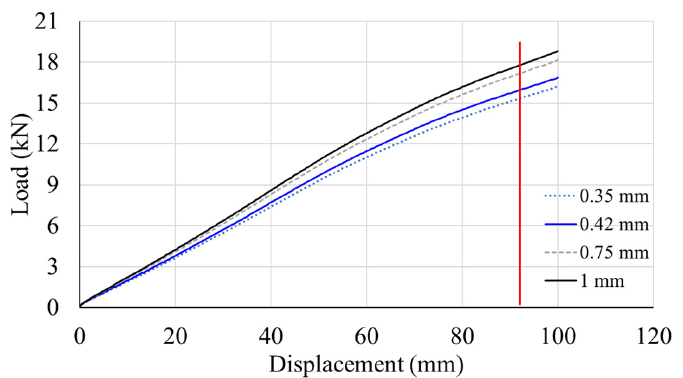
Figure 10. Load–displacement curves for decks of varying thickness of top-hat ribs.